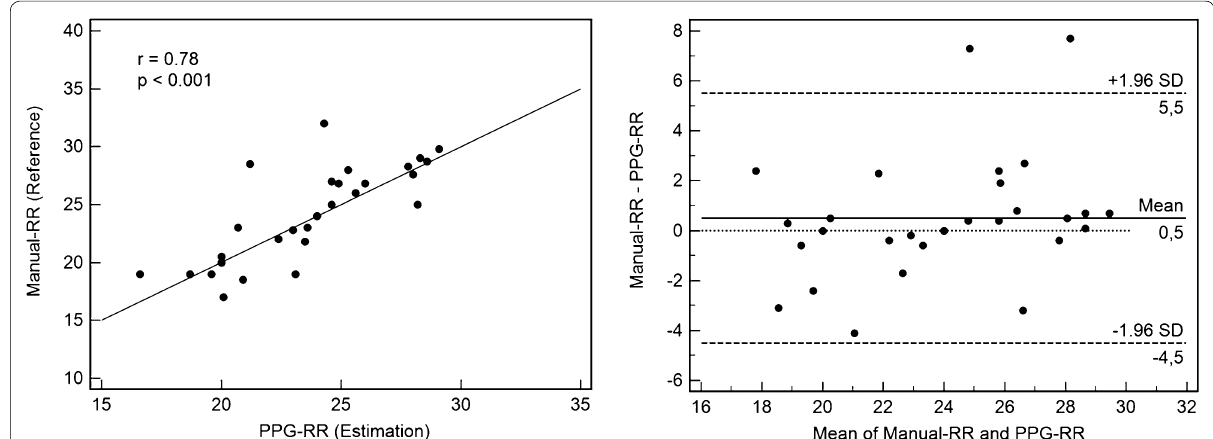
Fig. 2 Correlation and Bland–Altman plot for reference and estimated respiratory rate during the prospective evaluation phase. Reference respiratory rate (RR) values are provided as the chronometric measurement measured over 30 s under spontaneous ventilation or as the ventilatory rate for patients under ventilatory assistance. Estimated RR was performed using the plethysmographic curve analysis (RR‑PPG). On the 30 ICU patients’ recordings, prospective estimation of the RR‑PPG was well correlated with the reference method ( r methods using the Bland–Altman method depicted a low bias (0.5 c/min) and acceptable deviation (< were related to difficult PPG signal acquisition, mostly due to artefacts and/or bad